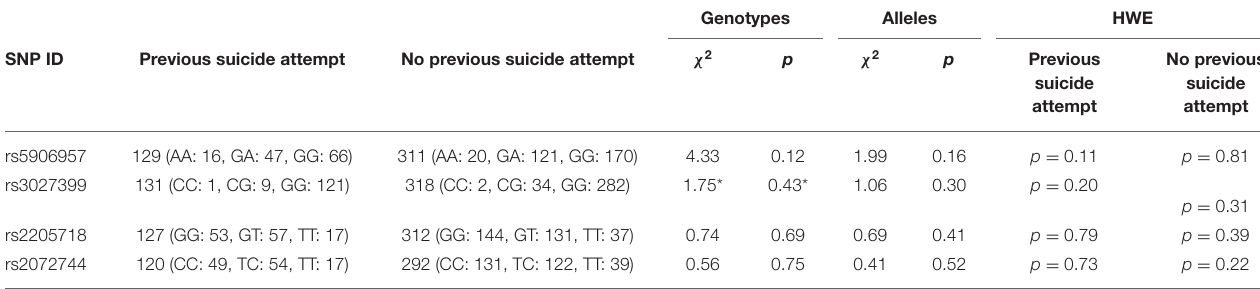
TABLE 2 | Personal history of suicide attempt(s) vs. no history of suicide attempt in female affective disorder patients, single marker analyses were established with standard chi-squared testing.